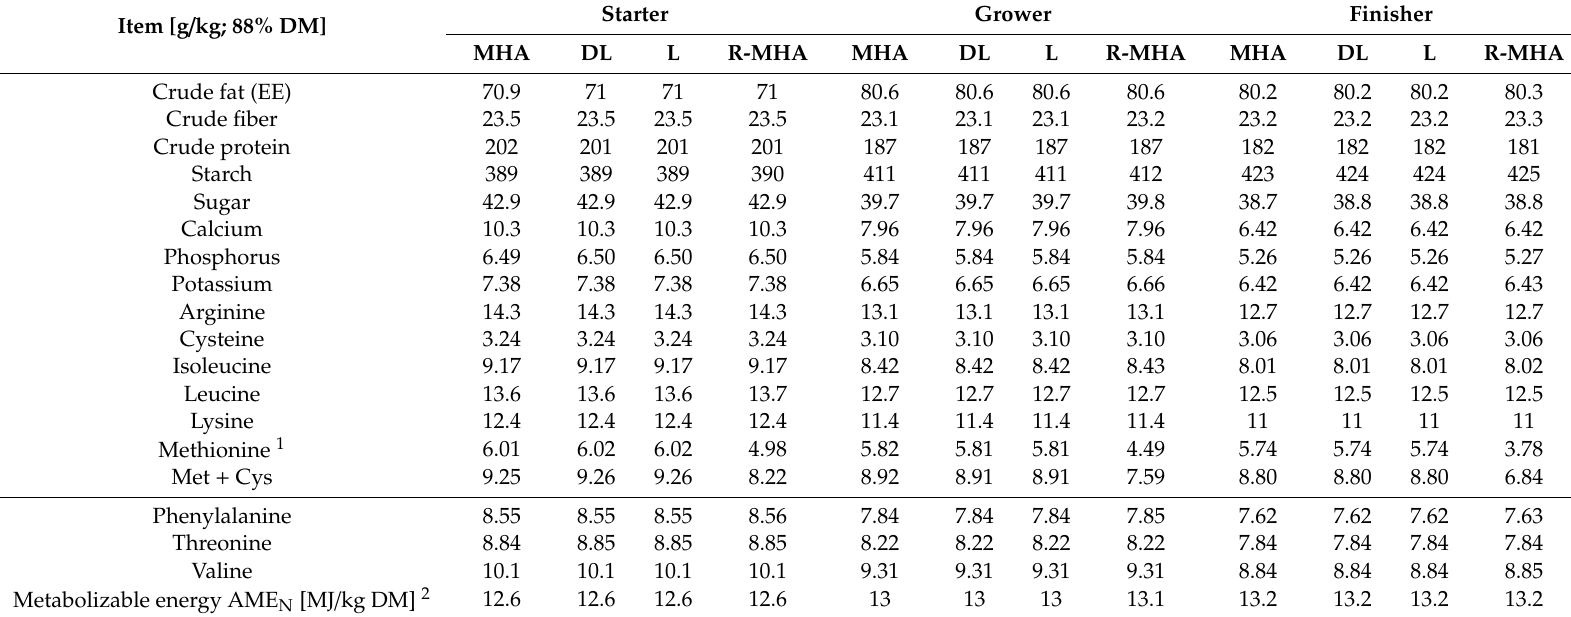
Table 2. Template: Calculated nutrient composition of ingredients in the starter, grower, and finisher